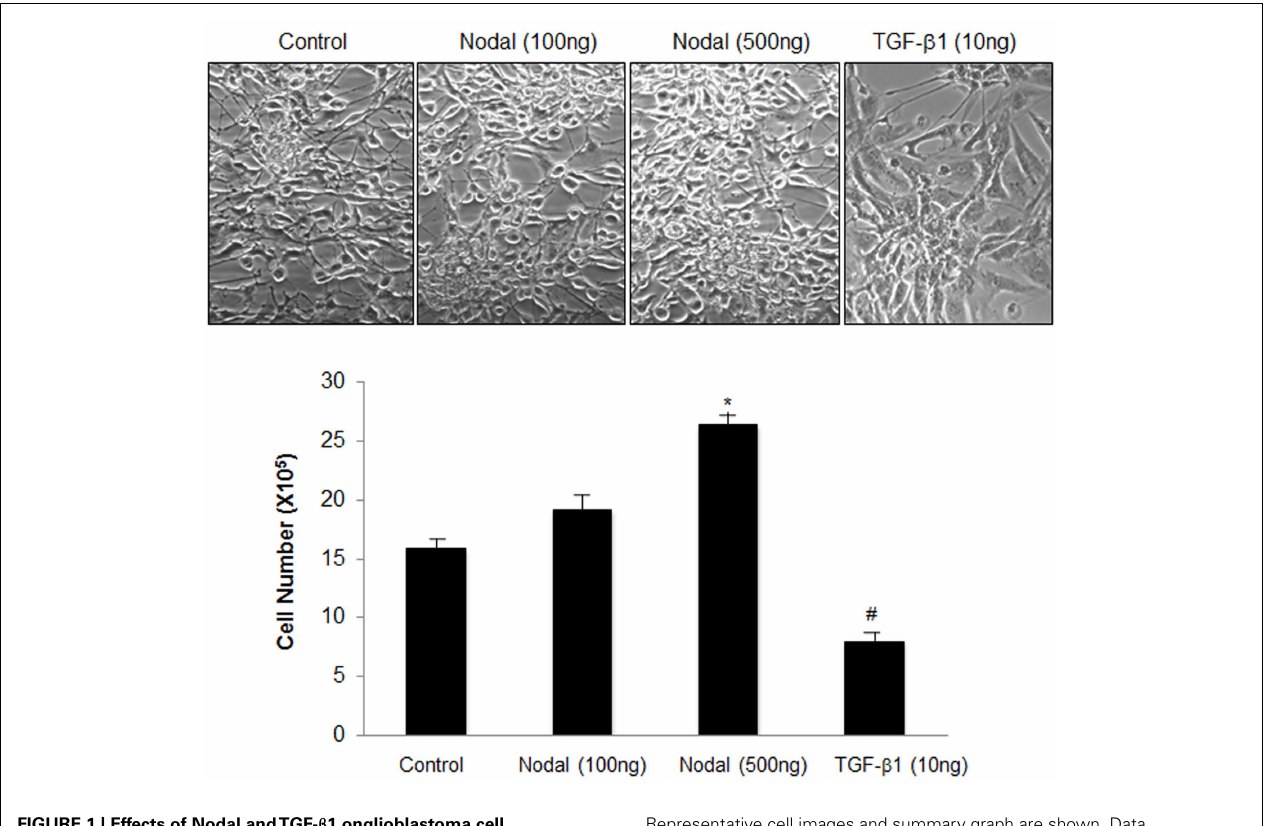
FIGURE 1 | Effects of Nodal andTGF- β 1 onglioblastoma cell growth. U87 cells cultured in 24 well plates were treated with either recombinant Nodal (100 or 500ng/ml) orTGF- β 1 (10ng/ml) for 48h. Cell numbers were determined by trypan blue exclusion.